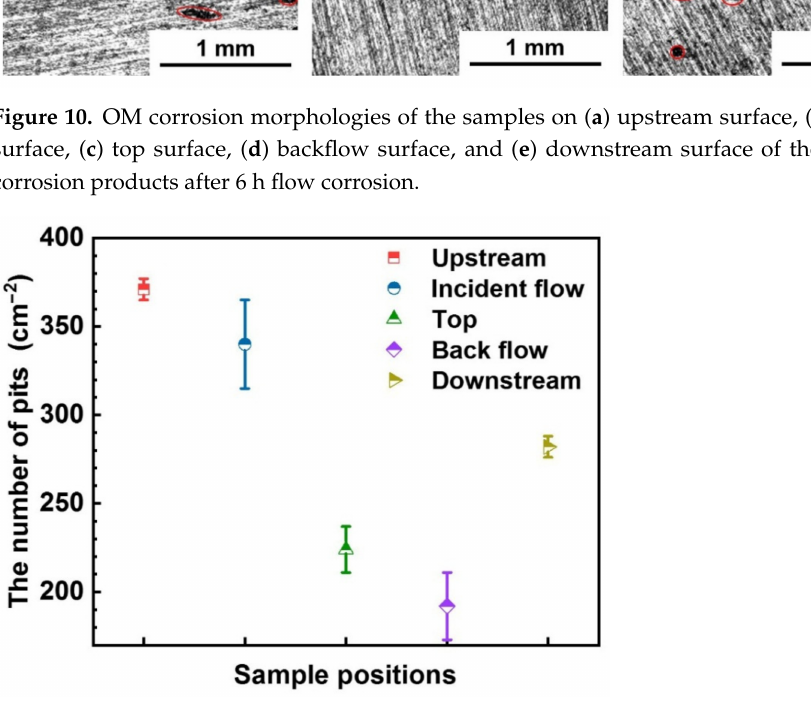
Figure 11. The number of pits on each surface of the WRH after removing the corrosion